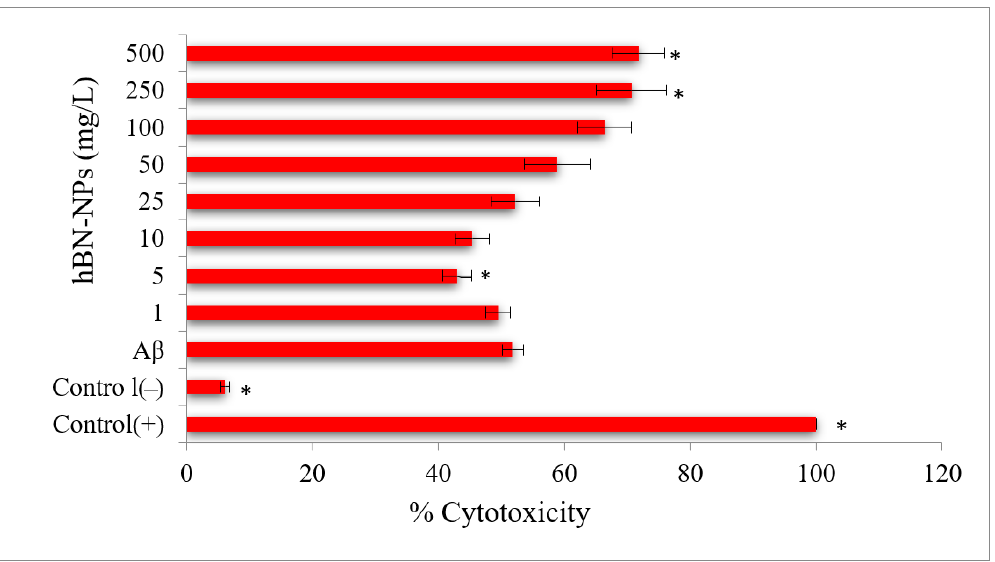
Figure 8. Effects of hBN-NPs on A β toxicity in cultured differentiated human SH-SY5Y cells as measured by LDH release assay. (Control ( − ): Cells without hBN-NPs; Control (+): Cell treated with Triton-X. * Symbol presents significant differences at the p < 0.05 level from the A β group). TAC and TOS levels were carried out to understand the associated mechanism be-